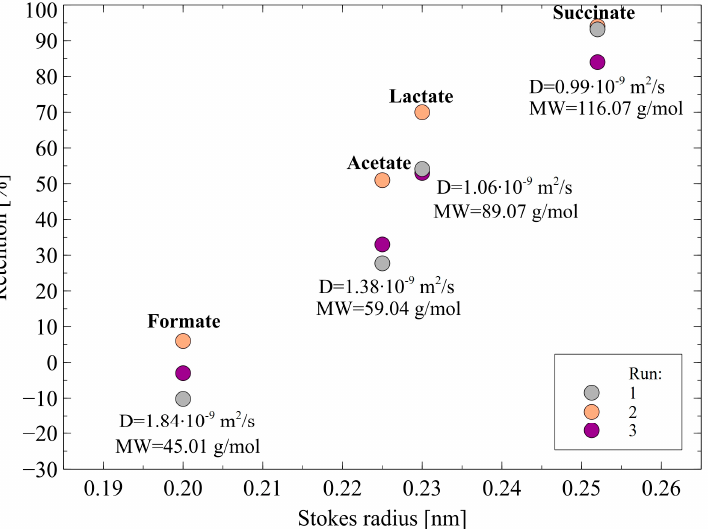
Figure 9. Retention of organic acids in function of Stokes radius during the NF process. TMP = 1.4 MPa, T = 298 K, J = 30 L/m 2 h. T = 298 K, J = 30 L/m 2